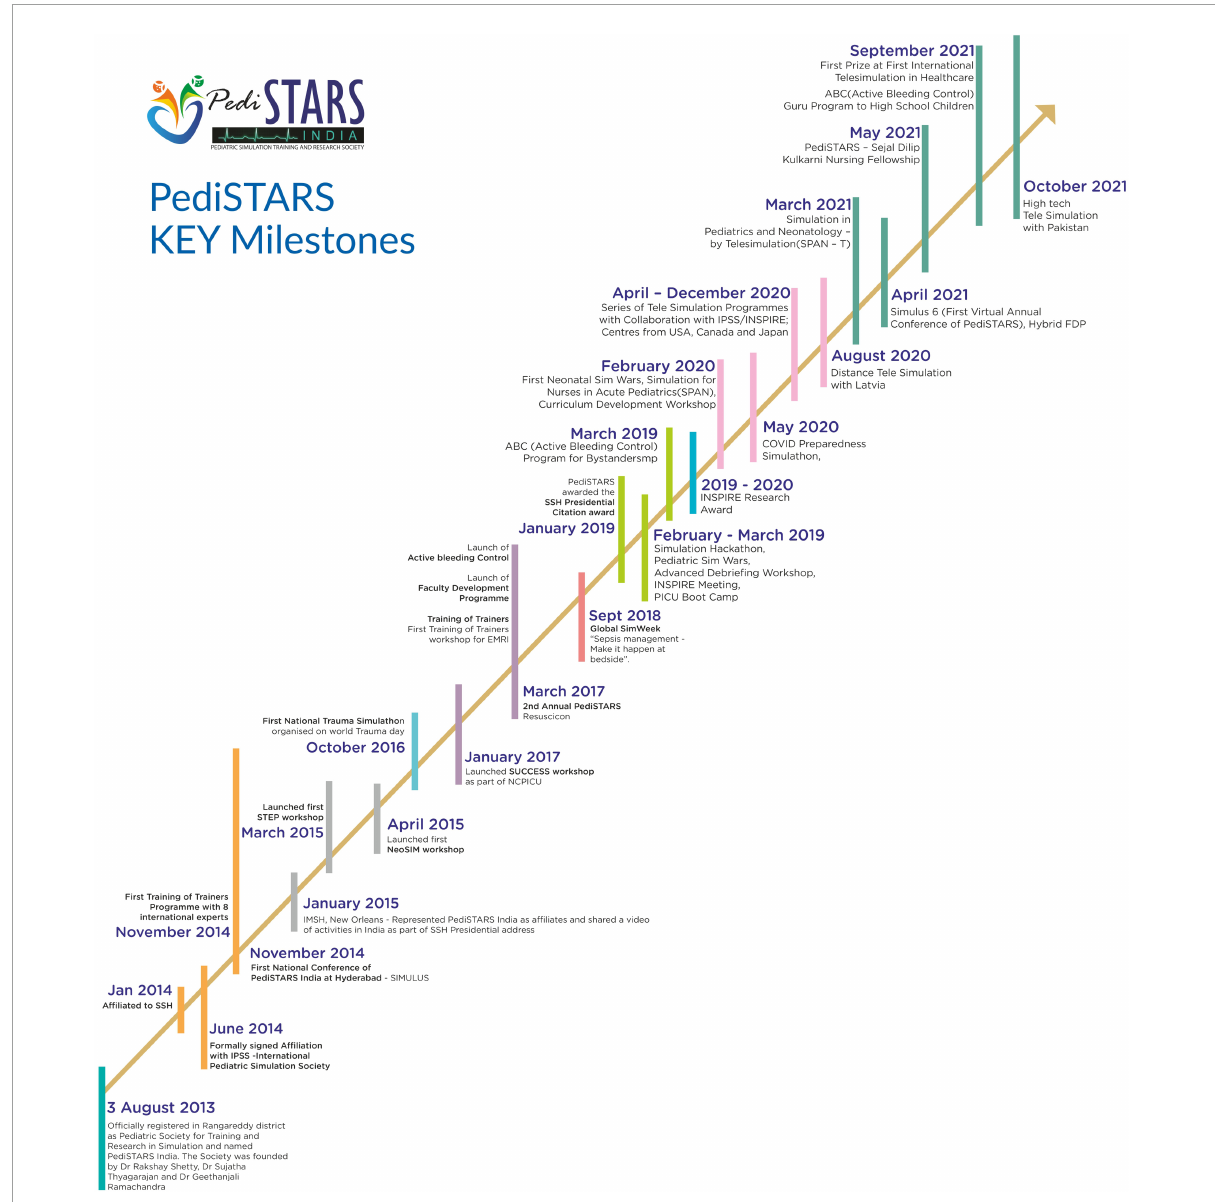
FIGURE1 PediSTARS Key